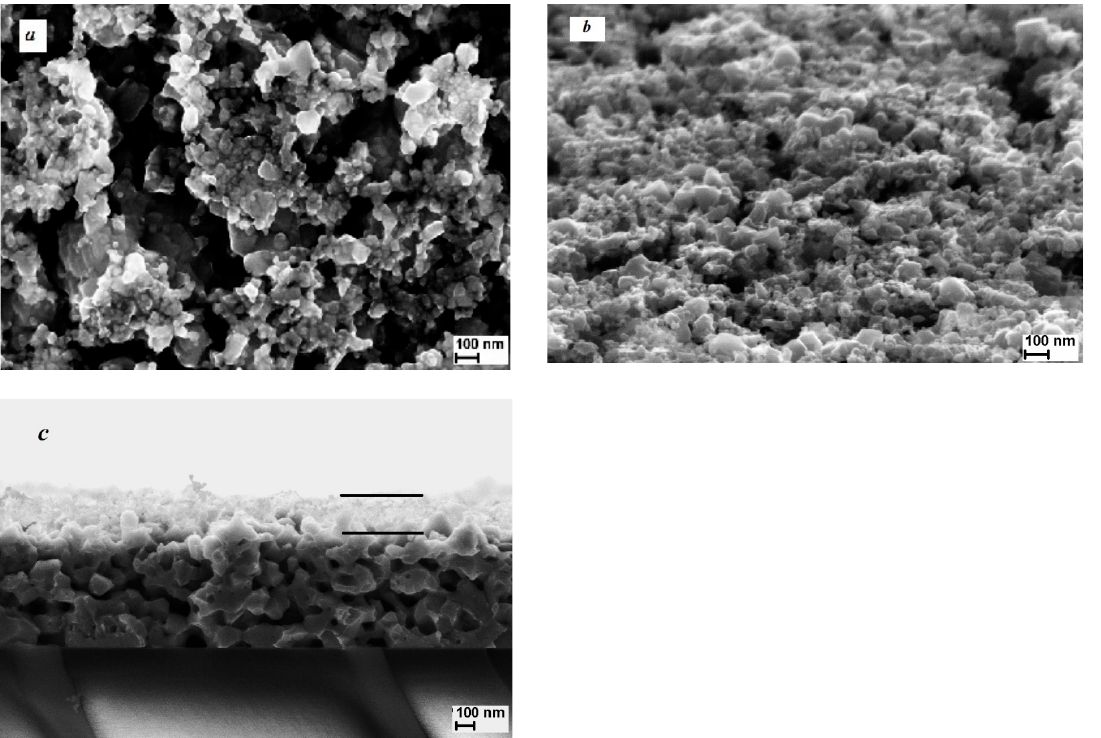
Figure 1. SEM images of the surface ( a , b ) and cross-section ( c ) of the film in a pristine state. The sample tilt during imaging was ( a ) 0° and ( b ) 70°.